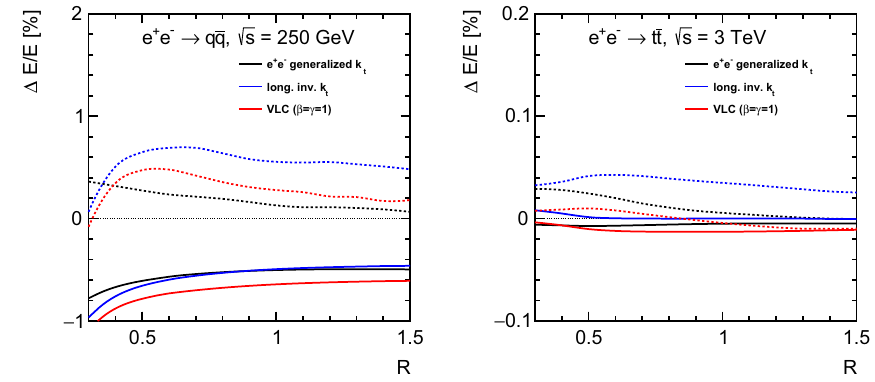
Fig. 6 Non-perturbative jet energy corrections to the jet energy as a function of the jet radius parameter R in e + e − → q ¯ q production at √ s = 250 GeV (left panel) and e + e − → t ¯ t production at (right panel). The continuous line corresponds to the median relative